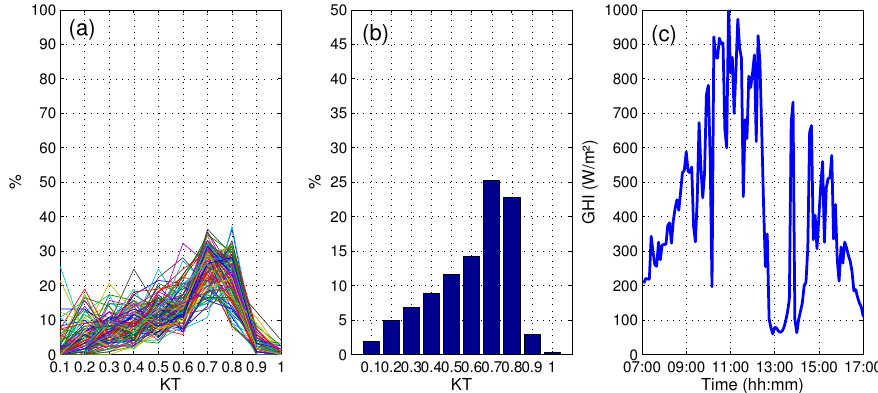
Figure 13. Class representing intermittent cloudy sky day event: ( a ) clearness index of 111 intermittent cloudy sky days; ( b ) average K t histogram of the 111 intermittent cloudy sky days; and ( c ) an intermittent cloudy sky day GHI